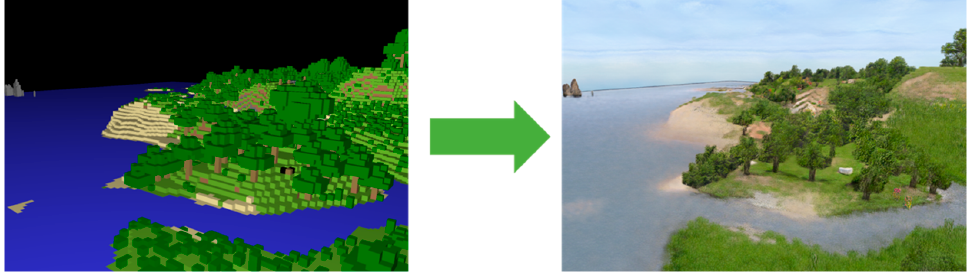
Figure 4. An example crude voxel input with generative photorealistic output from GANcraft.